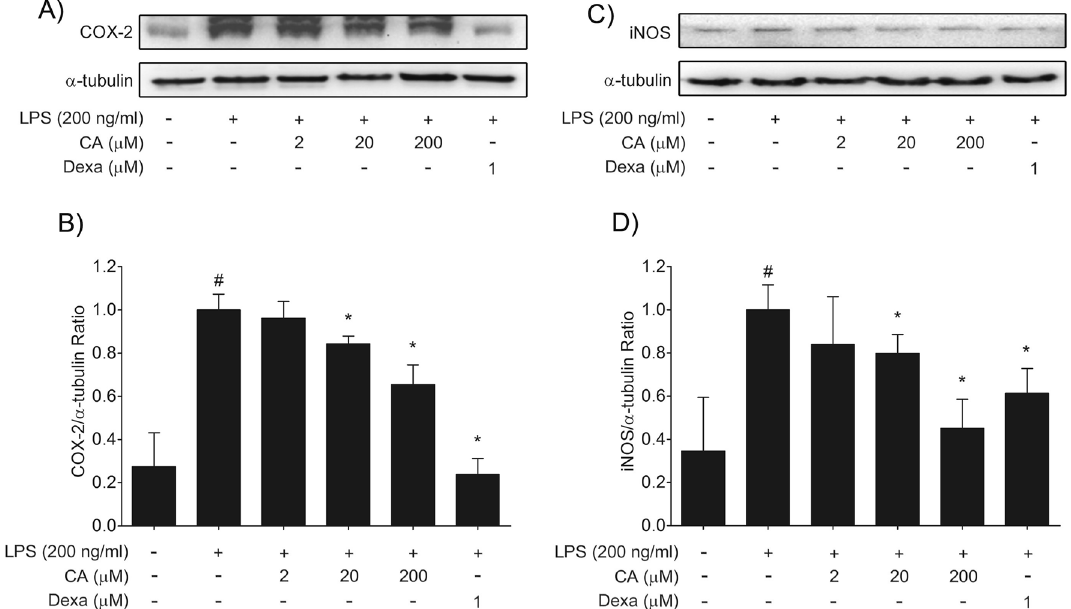
10 6 cell/well) were pretreated with various × S.D. of duplicate ±